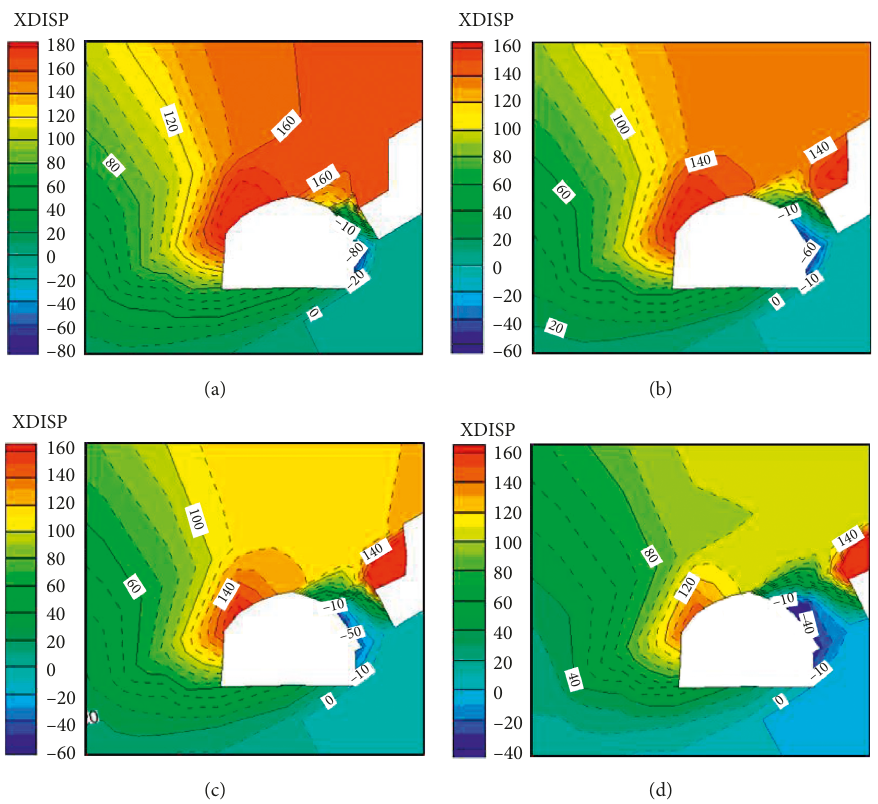
Figure 18: Horizontal displacement distributions of different GSSB widths: (a) 0.5m,(b) 0.75m, (c) 1.0m, and (d) 1.5m.